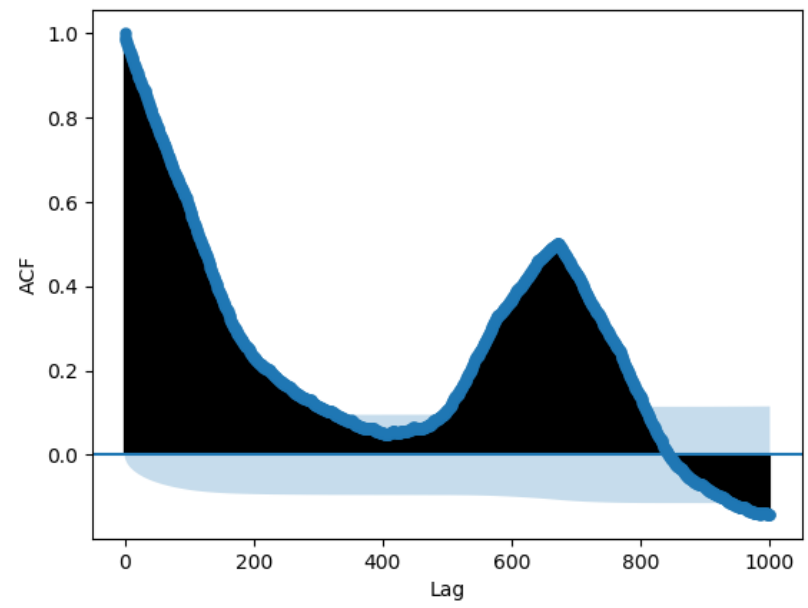
Figure 3. Autocorrelation analysis of the load